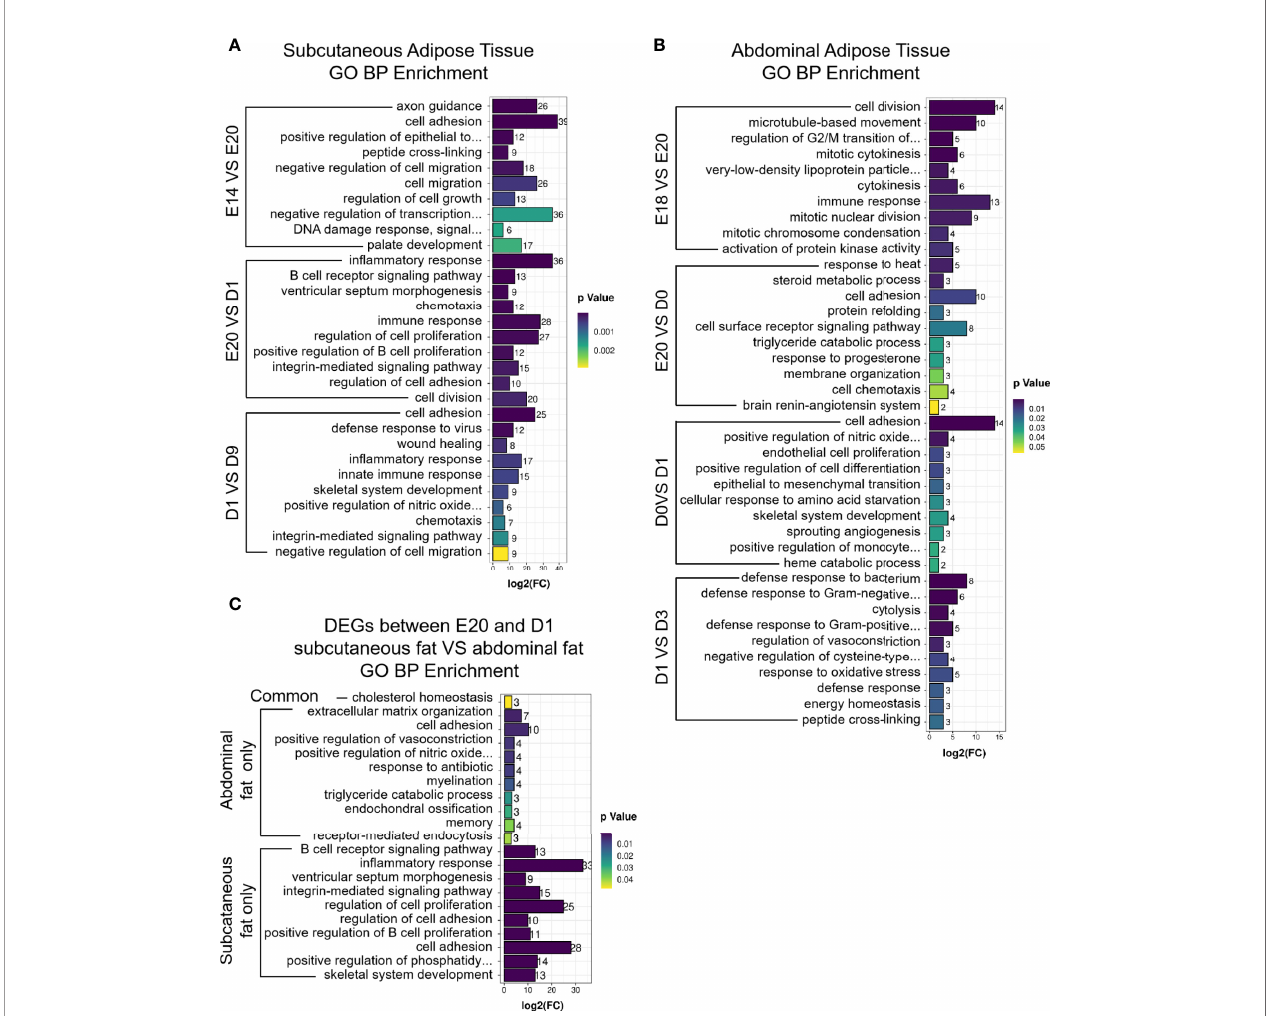
FIGURE 5 | GO enrichment of DEGs between different development stages in chick subcutaneous and abdominal adipose tissues. (A) GO enrichment of DEGs between different development stages in chick subcutaneous adipose tissue; (B) GO enrichment of DEGs between different development stages in chick abdominal adipose tissue; (C) GO enrichment of Venn analysis of DEGs between subcutaneous adipose tissue and abdominal adipose tissue (E20 vs.